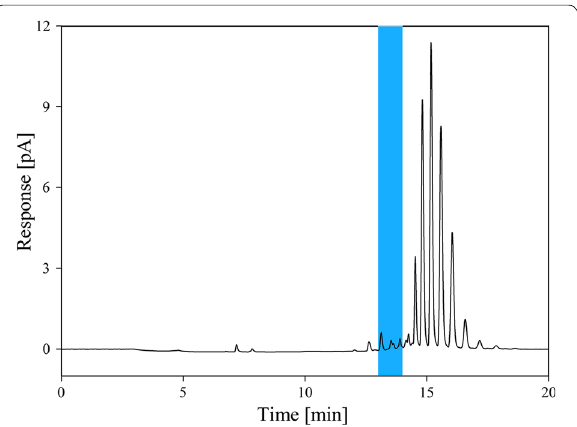
Fig. 3 Chromatogram of crude SBO. The peak area at 13.6 min could be assigned to lecithin (marked in